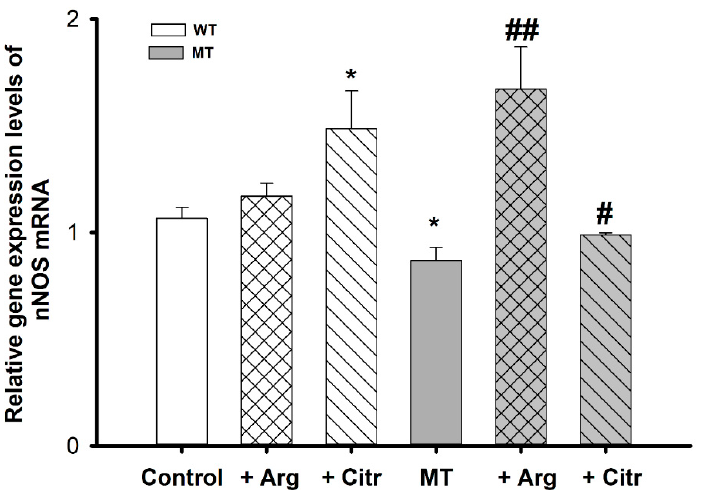
Figure 3. nNOS mRNA expression levels in ALS cell lines measured using qPCR. Each value represents the mean ± SEM ( n = 3–4). * p < 0.05, indicate significant differences with respect to the control. # p < 0.05, ## p < 0.01, significant differences vs. MT.